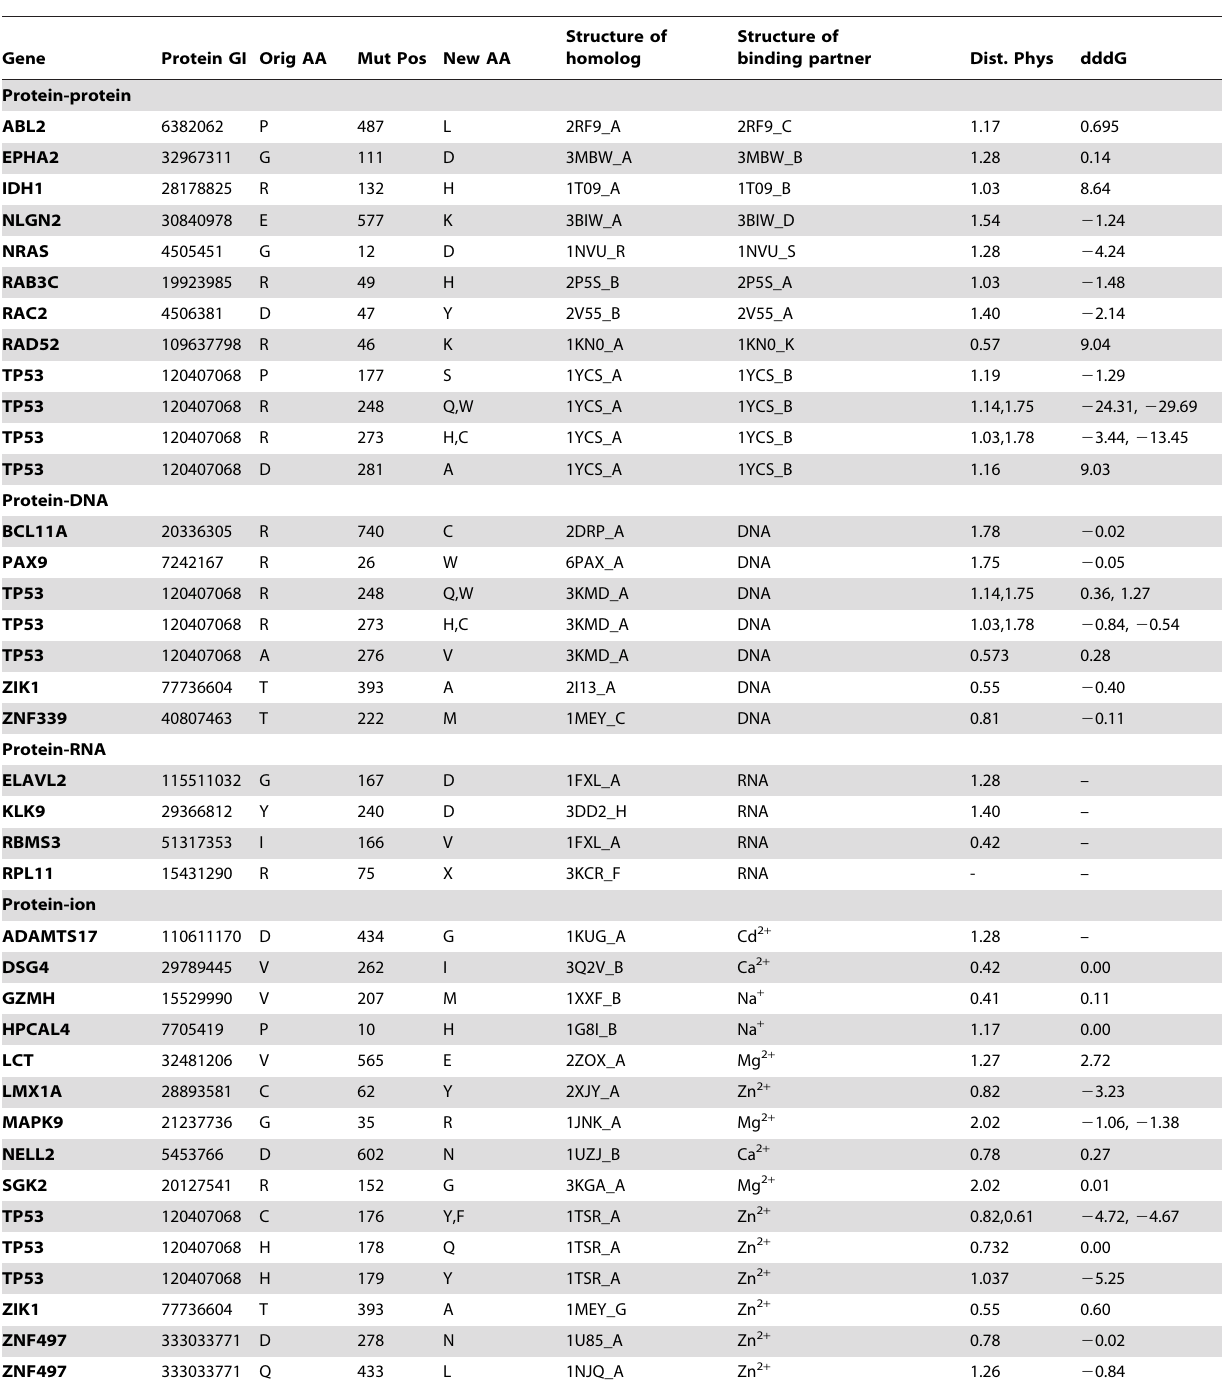
Table 1. List of representative genes with mutation sites located on different types of protein binding interfaces.